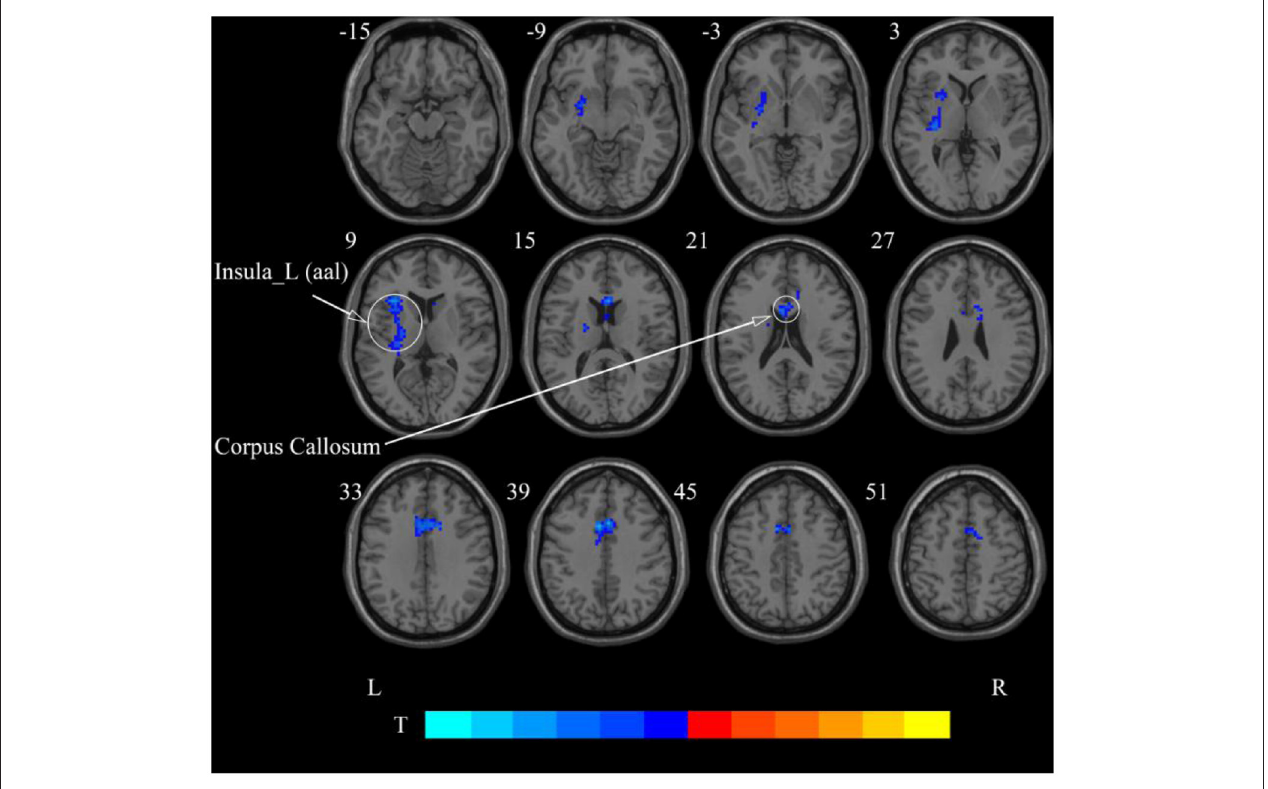
FIGURE 7 | Statistical maps showing ReHo change pre- and post-rTMS in the slow-4 band. Cool colors showing ReHo decreased after rTMS p < 0.05.